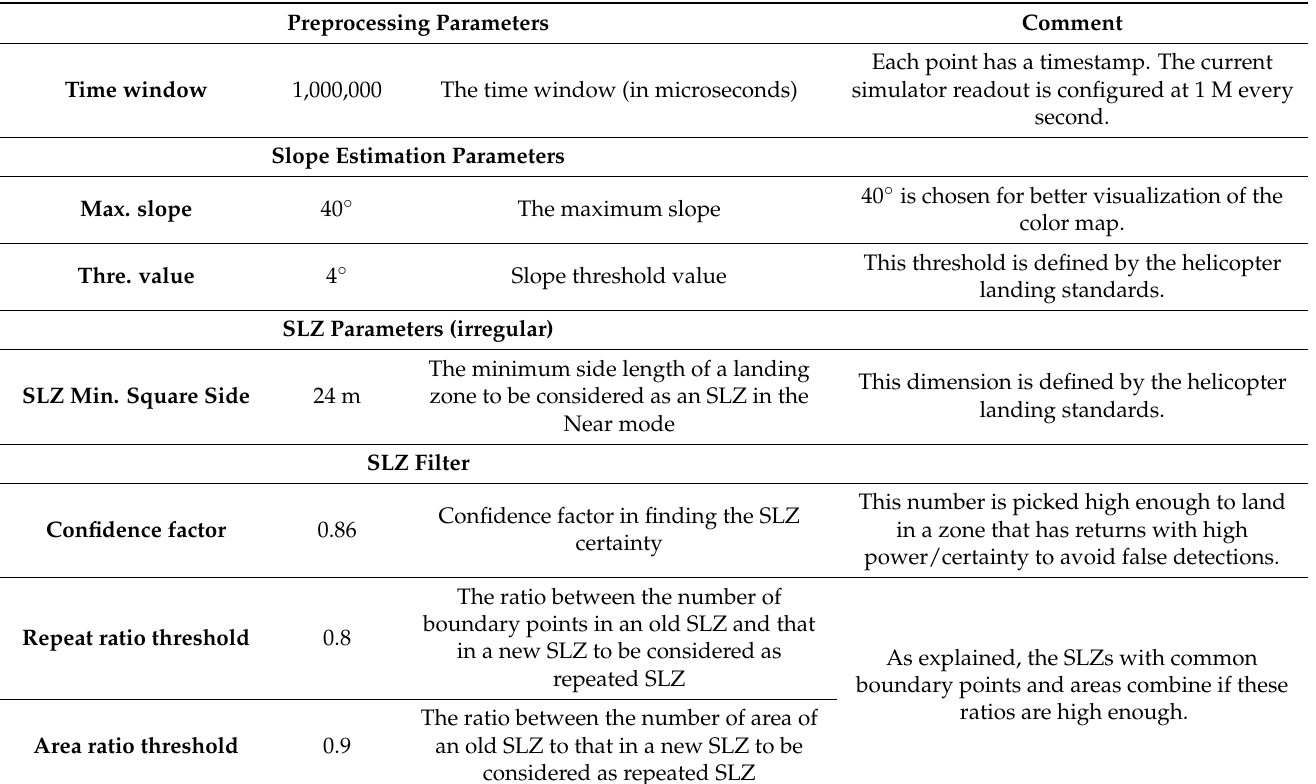
Table 4. Algorithm